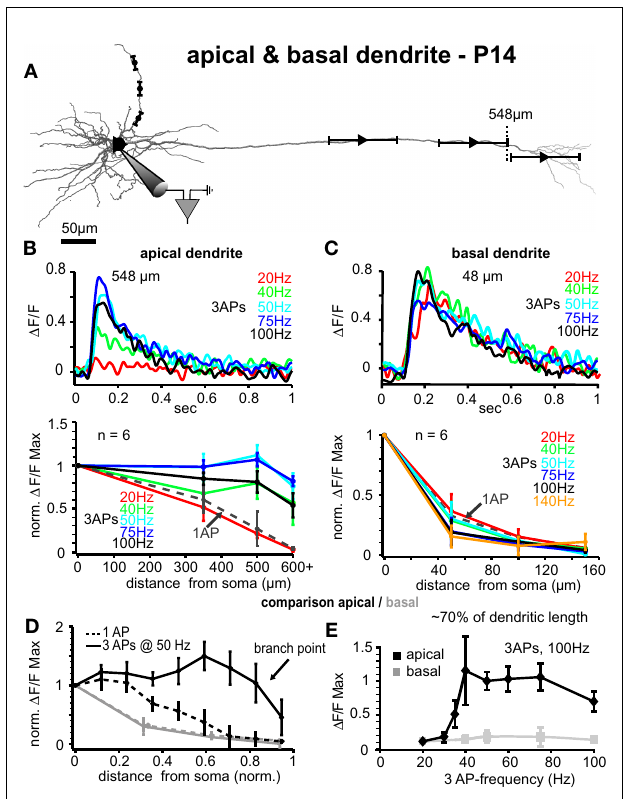
FIGURE 6 | Comparison between apical and basal dendrites at P14. (A) Reconstruction of a L5A pyramidal neuron at P14. Trains of three APs were evoked by current injections into the soma and calcium measurements were taken at the soma and at three different distances along either the apical dendrite or the basal dendrite (indicated by the symbols and ranges). (B) Apical dendrites, upper panel . Ca 2 + transients ( Δ F/F) evoked by trains of three APs at different fi xed frequencies measured at the main apical dendrite close to the major branch point (548 µm from soma, see arrow) in a P14 L5A pyramidal neuron. Frequencies ranged from 20 Hz to 100 Hz. Note that the maximal response was evoked at 50 Hz. Lower panel . Peak amplitudes of Ca 2 + transients ( n = 6) evoked by trains of three APs at different frequencies are normalized to the somatic values and plotted as function of distance from soma. For comparison, Ca 2 + transients evoked by single APs (dashed line) are also shown. Average values are mean ± sem. Note that the frequency is becoming increasingly important at distances from soma more distal than 300 µm, and that signals drop off steeply beyond the major branch point within the apical tuft. (C) Basal dendrites, upper panel . Ca 2 + transients ( Δ F/F) evoked by trains of three APs at different fi xed frequencies measured at the basal dendrite ∼ 50 µm from soma in a P14 L5A pyramidal neuron. Frequencies ranged from 20 to 100 Hz. Lower panel . Peak Δ F/ F Ca 2 + signals evoked by single APs and short trains of three APs at different fi xed frequencies ranging from 20 to 140 Hz are normalized and plotted against distance from soma along the basal dendrites ( n = 6). Note that there is no signifi cant difference in the effi cacy of back-propagation within this frequency range. (D,E) Comparison of apical versus basal dendrites. (D) Peak Ca 2 + signals elicited by single APs and trains of three APs at 50 Hz were normalized and plotted as function of distance from soma. Distances along the basal and apical dendrites were normalized with respect to the total length of the dendrites to enable comparison of back-propagation effi cacy across different dendrite compartments. Note the signifi cant differences in back-propagation for apical and basal dendrites . (E) Differences in frequency-dependence are compared for a normalized distance of ∼ 70% along the basal (80–100 µm) and apical (400– 500 µm) dendrites. Ca 2 + signals evoked by trains of three APs at different frequencies were normalized to the 20-Hz train. Note the steep amplifi cation in Ca 2 + infl ux at the apical dendrite with increasing frequency.